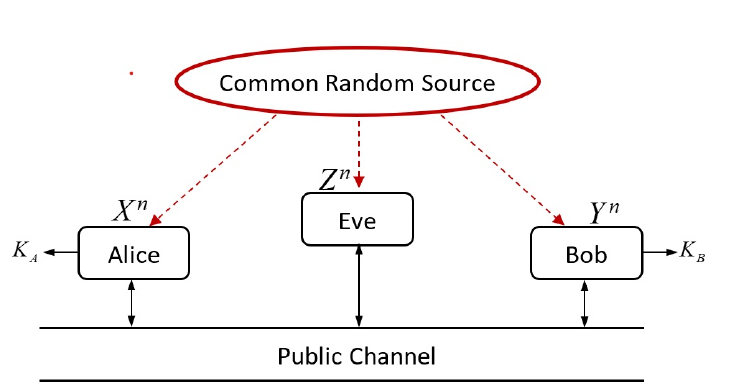
Figure 4 – Model of the execution environment for the Information theoretic based symmetric key establishment